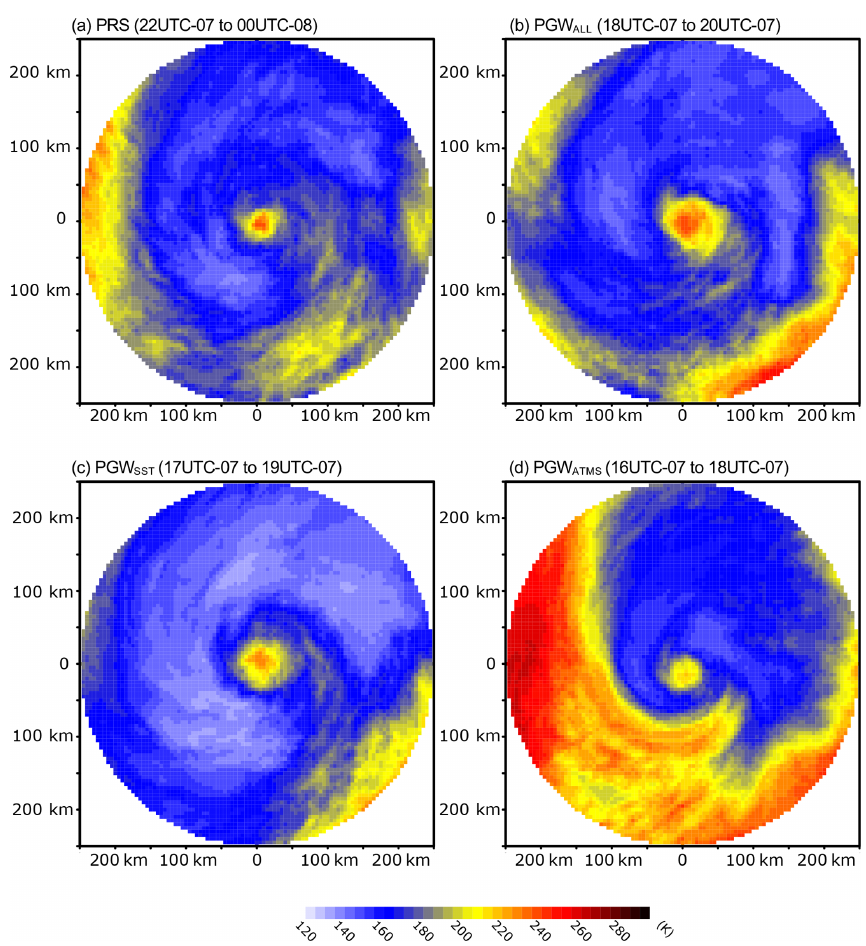
Figure 12. Same as for Fig. 10, but for outgoing longwave radiation (OLR) during intense rainfall in Fig.